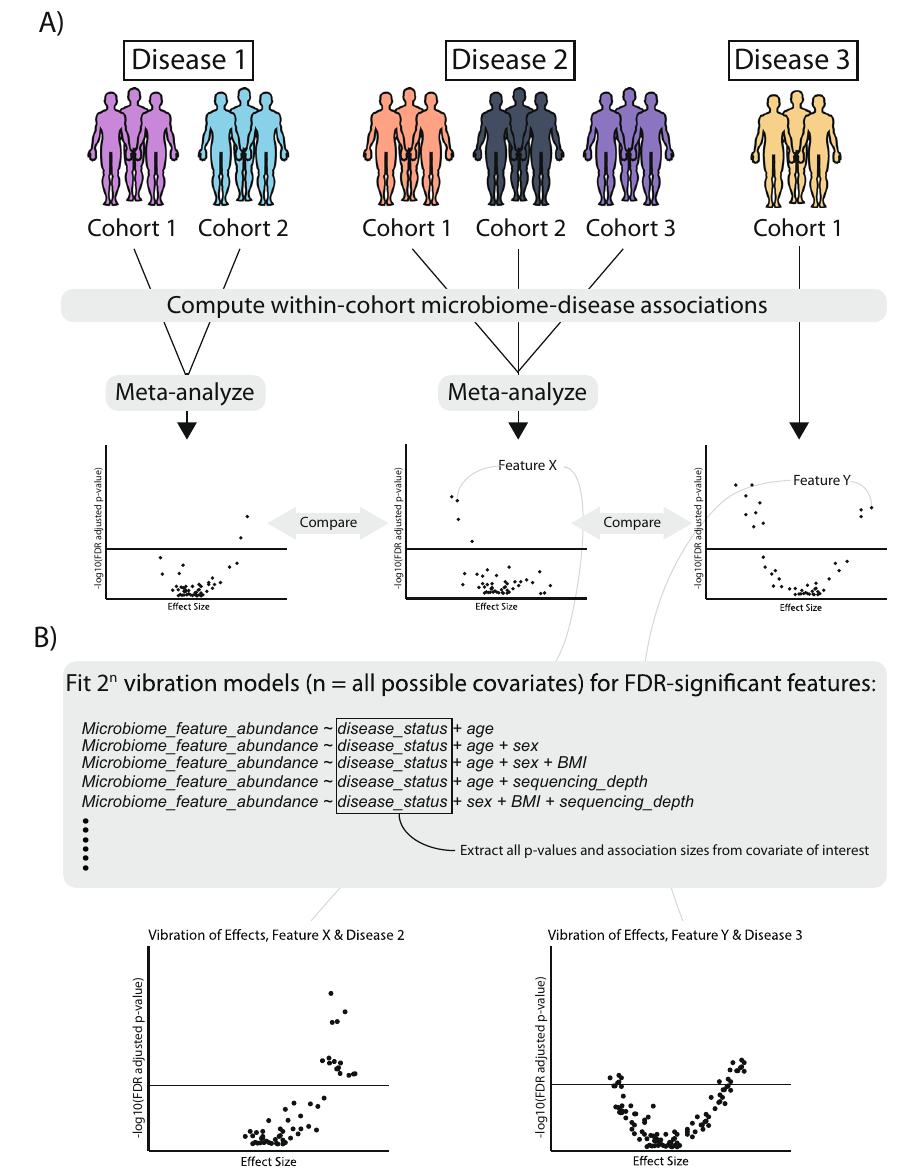
Fig. 1 Pipeline overview. A Using publicly available metagenomic, shotgun sequencing datasets, we computed linear associations between microbiome features (gene family, pathway, or species abundances) and for each of seven different diseases separately. In cases where multiple cohorts were present for one disease, we meta-analyzed the association output. B We then computed Vibration of Effects (VoE), where, given the available individual-level metadata, we determined how model speci fi cation changes the association between each false-discovery rate signi fi cant feature and host